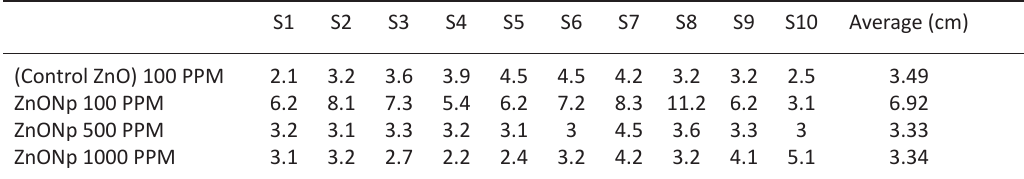
Table 2. Effect of ZnONp on Root Length(cm) of Lentil ( Lens esculentum ) S1 S2